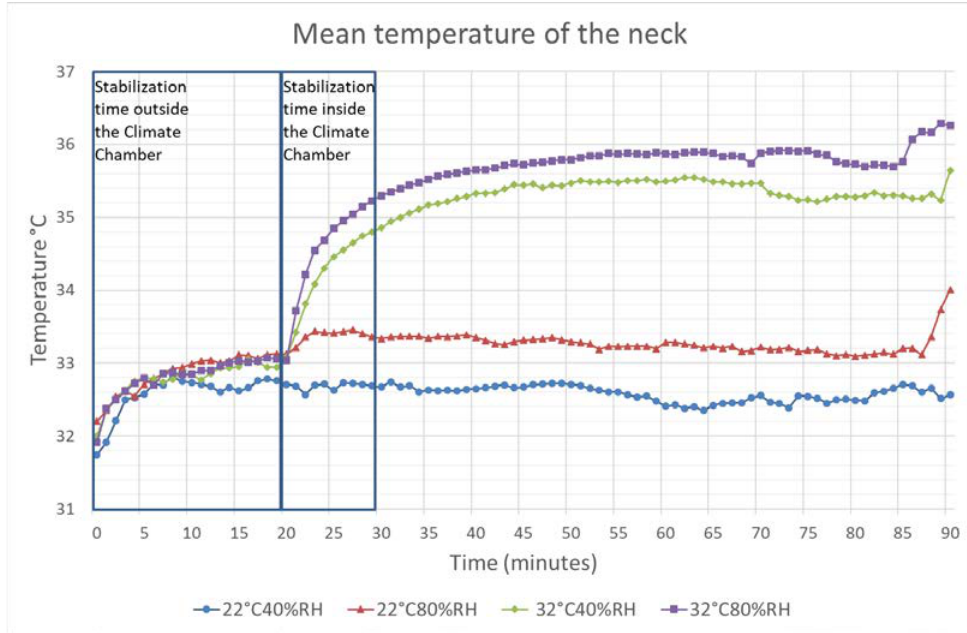
Figure 4. Neck mean temperature in different environmental